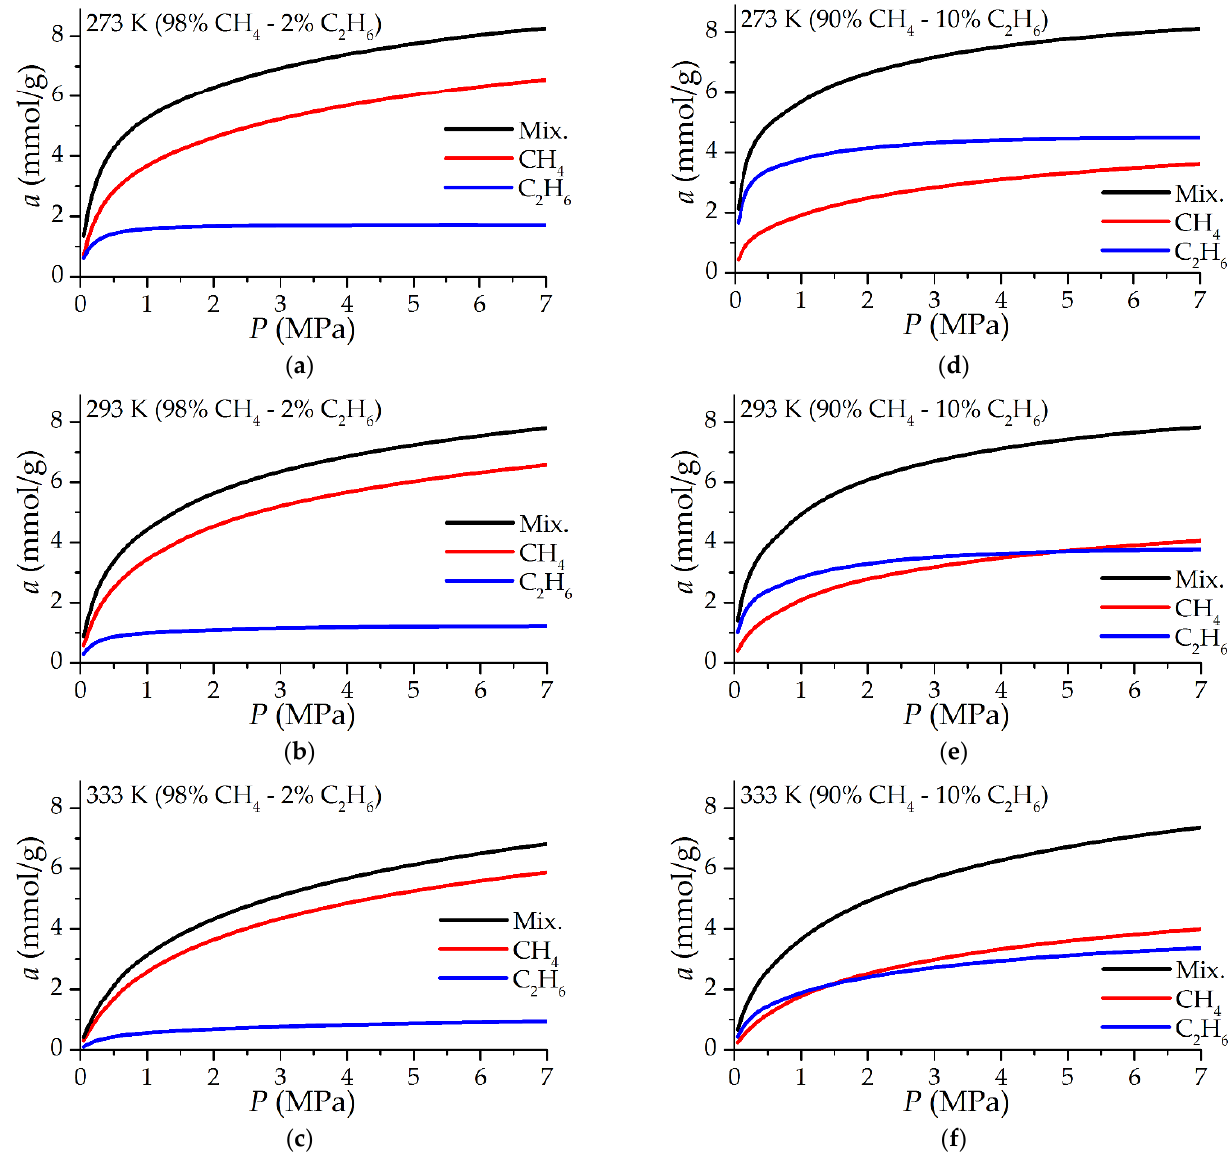
Figure 9. Equilibrium adsorption of a binary mixture of methane and ethane depending on the pressure of a gas mixture with a molar content of 2% ( a – c ) and 10% ( d – f ) ethane at temperatures of 273 K ( a , d ), 293 K ( b , e ), 333 K ( c , f ). The calculation method is IAST using experimental isotherms of pure components.